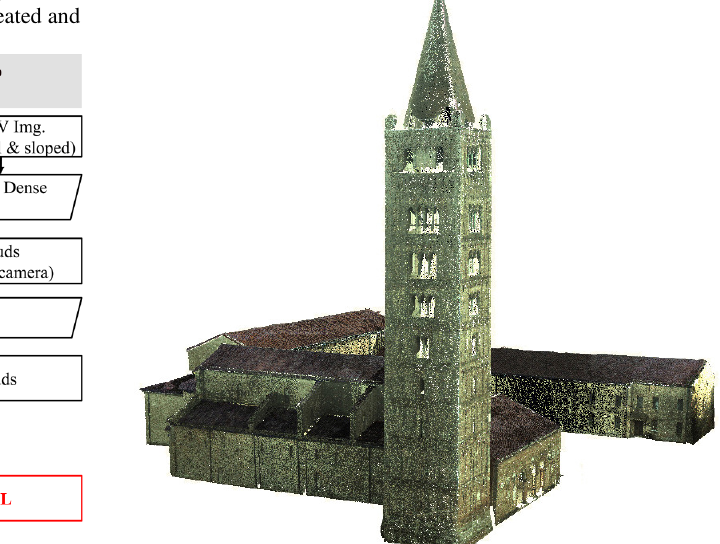
Figure 11. Main steps of the two pipelines and their integrations.